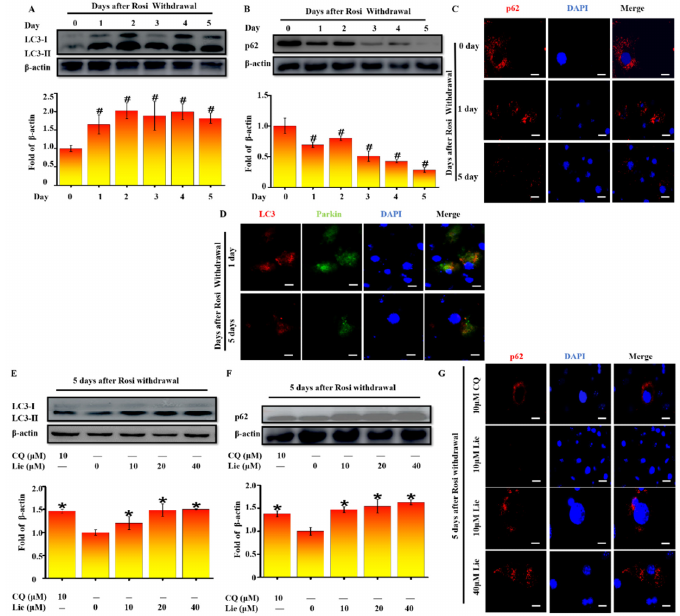
Figure 2. Lie blocked mitophagy after Rosi withdrawal in vitro. After Rosi withdrawal, immunoblotting for microtubule-associated protein 1 light chain 3 (LC3) at indicated time points (day 0–5) ( A ) A densitometric assay of each band. Fold change in optical density relative to day zero in the below of panel of A. After Rosi withdrawal, immunoblotting for selective autophagy adaptor protein (p62) at indicated time points (day 0–5) ( B ) And densitometric assay of each band. Fold change in optical density relative to day zero in the below of panel of B . After Rosi withdrawal, beige adipocytes stained with p62 antibodies at indicated time points ( C ) Scale bars, 20 mm. After Rosi withdrawal, beige adipocytes stained with LC3 and Parkin antibodies at indicated time points ( D ) Scale bars, 20 mm. After Rosi withdrawal, beige adipocytes were treated Lie (0, 10, 20 and 40 µ M) or chloroquine (CQ, 10 µ M) for 5 days. Western blot analysis showing the levels of LC3 ( E ) A densitometric assay of each band. Fold change in optical density relative to control (0 µ M Lie) in the below of panel of E . Western blot analysis showing the levels of p62 ( F ) A densitometric assay of each band. Fold change in optical density relative to control in the below of panel of F . Immunoblotting showing the of the levels of p62 ( G ) Scale bars, 20 mm. Values shown are means ± standard deviation (SD), # p < 0.05 vs. 0 day after Rosi withdrawal; * p < 0.05 vs. 0 µ M Lie